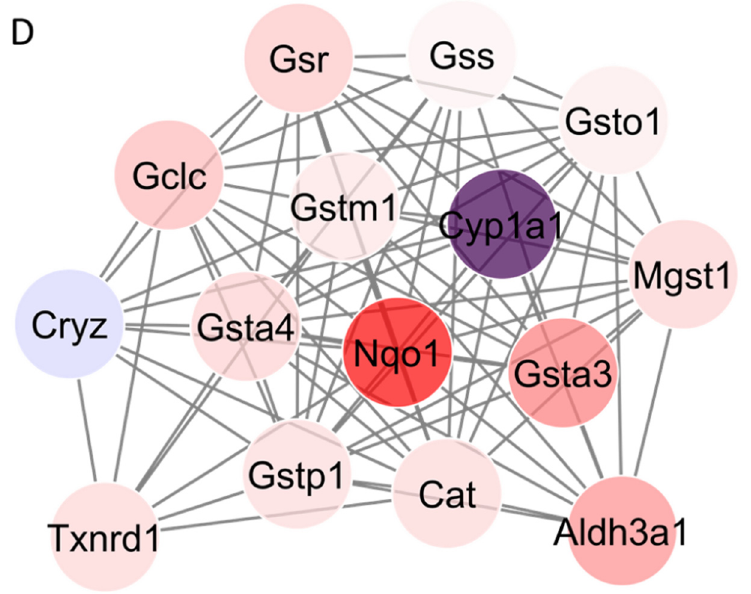
Figure 5. Protein–protein interaction (PPI) of differentially expressed proteins (DEPs) for the PG ( A ) and t-BHQ ( C ) treatments and hub proteins derived from the PPI of the PG ( B ) and t-BHQ ( D ) treatments. The color indicates the expression level of DEPs, with red indicating upregulation and blue indicating downregulation. Green-colored proteins were not in the DEPs but interacted with some of the DEPs; purple-colored proteins were highly induced proteins with a fold change >7. The widths of the edges were positively correlated with edge betweennesses. Results derived from four independent experiments. PG, pyrogallol; t-BHQ, tert-butylhydroquinone. Full form of the abbreviated protein names can be found in Supplementary Materials Table S2.